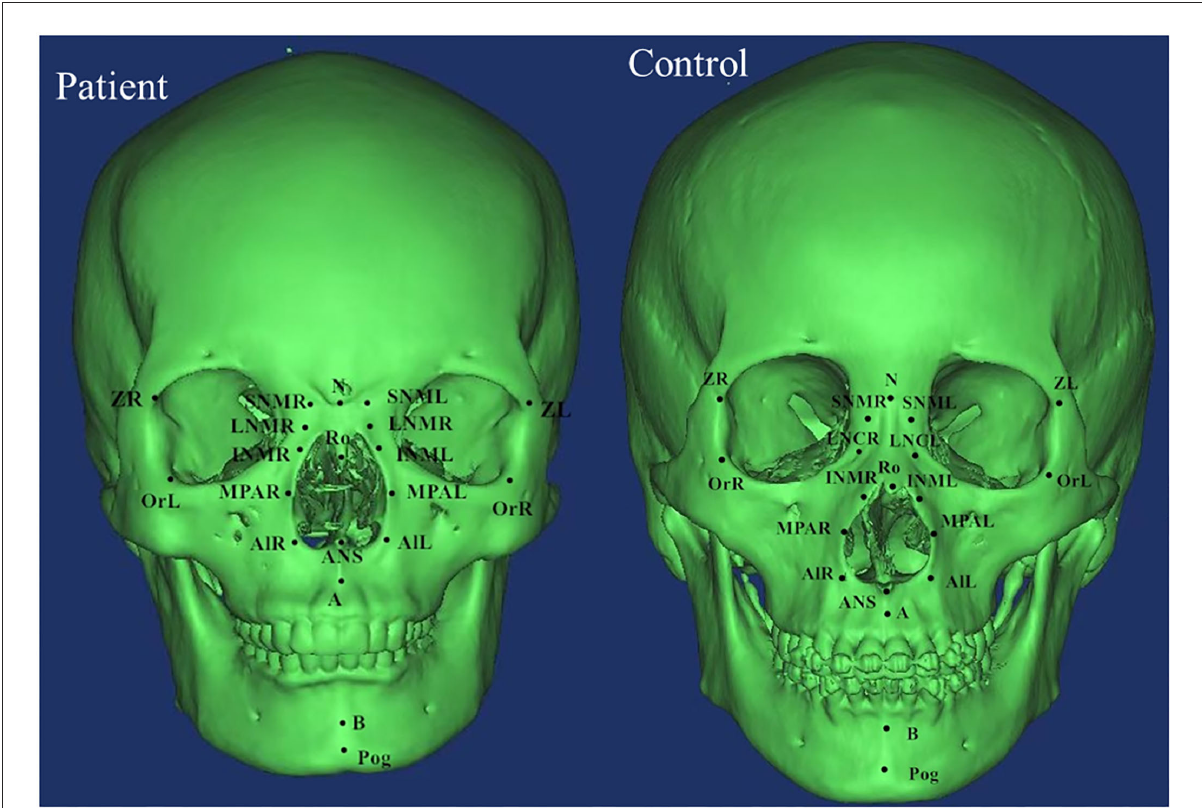
FIGURE1 The anatomical landmarks were shown on the computed tomographic scans (coronal